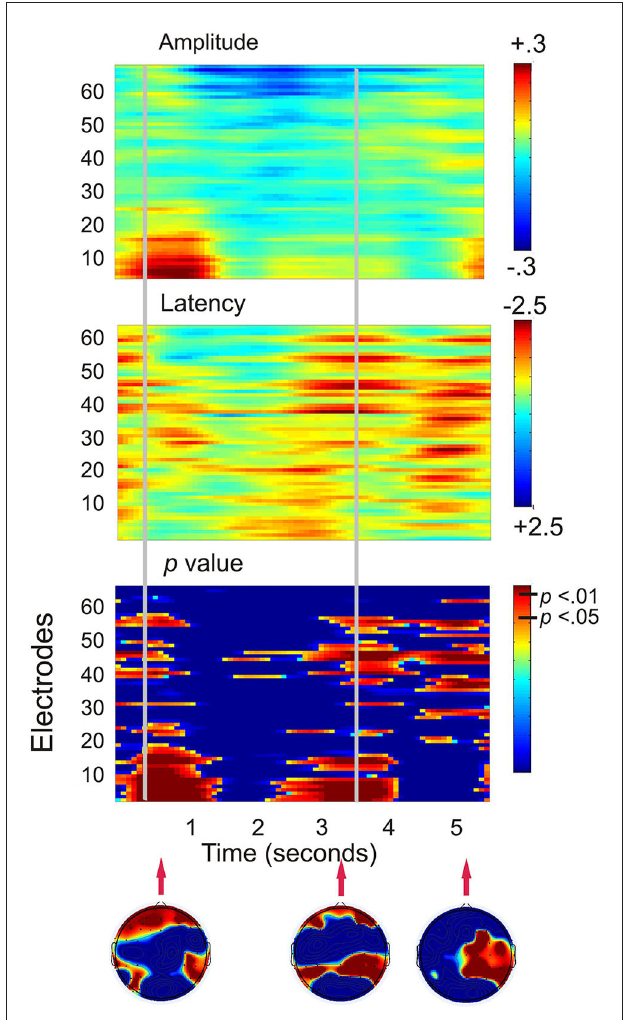
FIGURE 3 | Plots displaying the working memory task effects for all 130 participants (SSVEP amplitude and latency for the working memory task compared to the control task) . Time is presented on the x -axis and electrodes on the y -axis. Vertical event marker lines separate encoding, maintenance and retrieval stages of the task. Warmer colors indicate amplitude decreases and latency decreases for the spatial working memory task relative to the control task. Cooler colors indicate amplitude and latency increases. Hotelling’s T statistical significance is shown below, topographical maps display maximal statistical